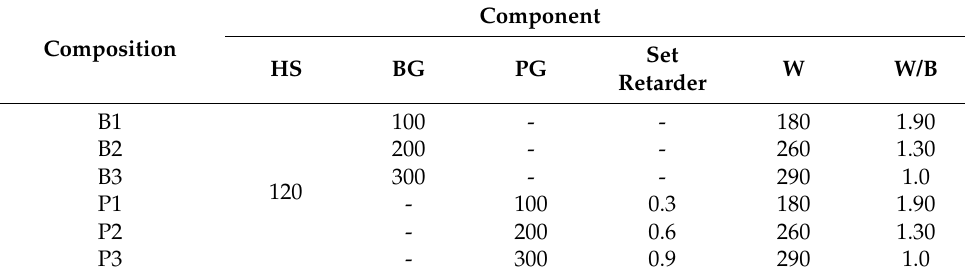
Table 2. Mixture compositions of gypsum-based BAC.